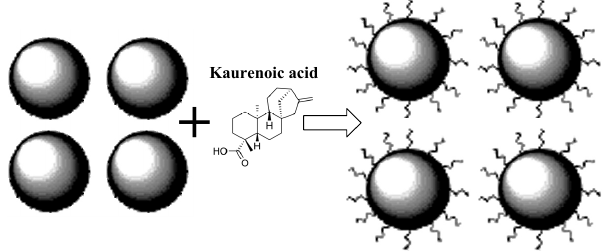
Figure 33. Scheme of the interaction between the as‑prepared magnetite nanoparticles and kaurenoic acid (containing polar groups) after dispersion in Copaiba oil. Adapted from Ref. [72] with permission from Elsevier: Spectrochimica Acta, Part A: Molecular and Biomolecular Spectroscopy, Vol. 152, Oshtrakh M.I., Ushakov M.V., Šepelák V., Semionkin V.A., Morais P.C., “Study of iron